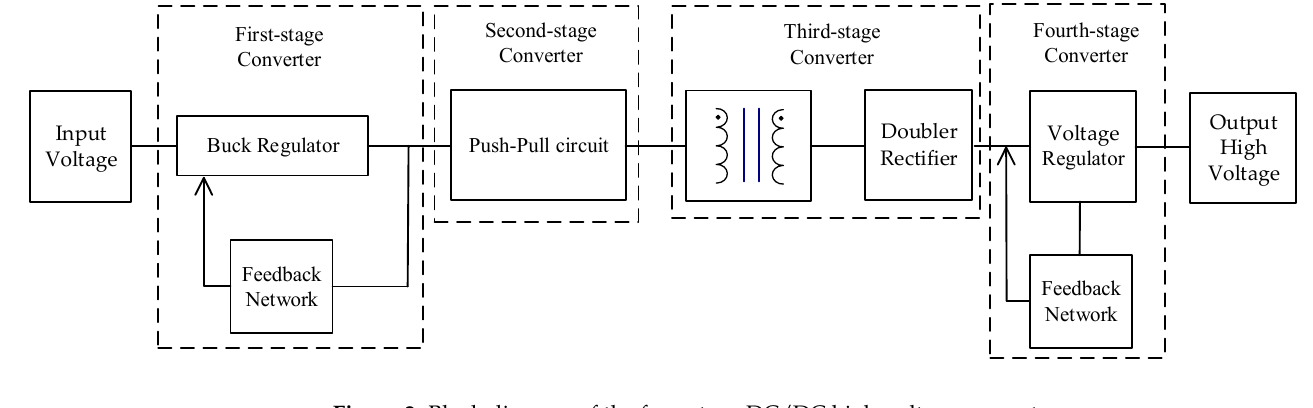
Figure 2. Block diagram of the four-stage DC/DC high-voltage converter.